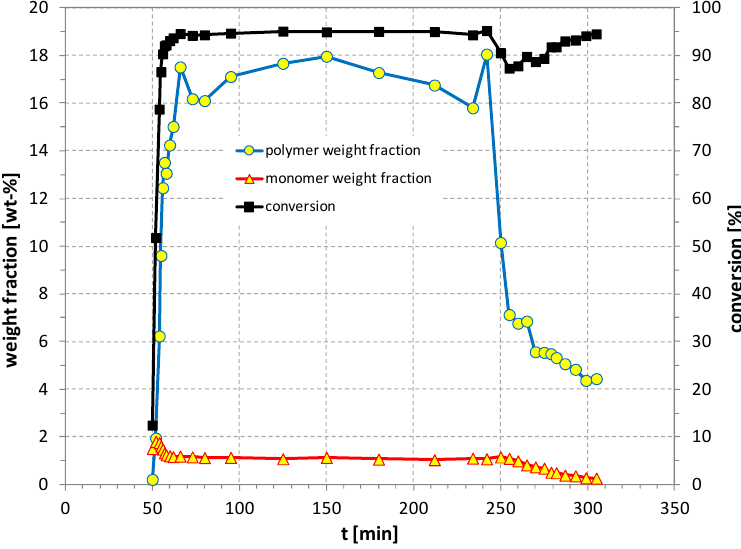
Figure 4. Polymer and monomer weight fraction profiles (to be read on the left y-axis) and conversion profile (to be read on the right y-axis) for the 500 mL RAFT polymerization of AAc in the continuous flow reactor, pAAc-6